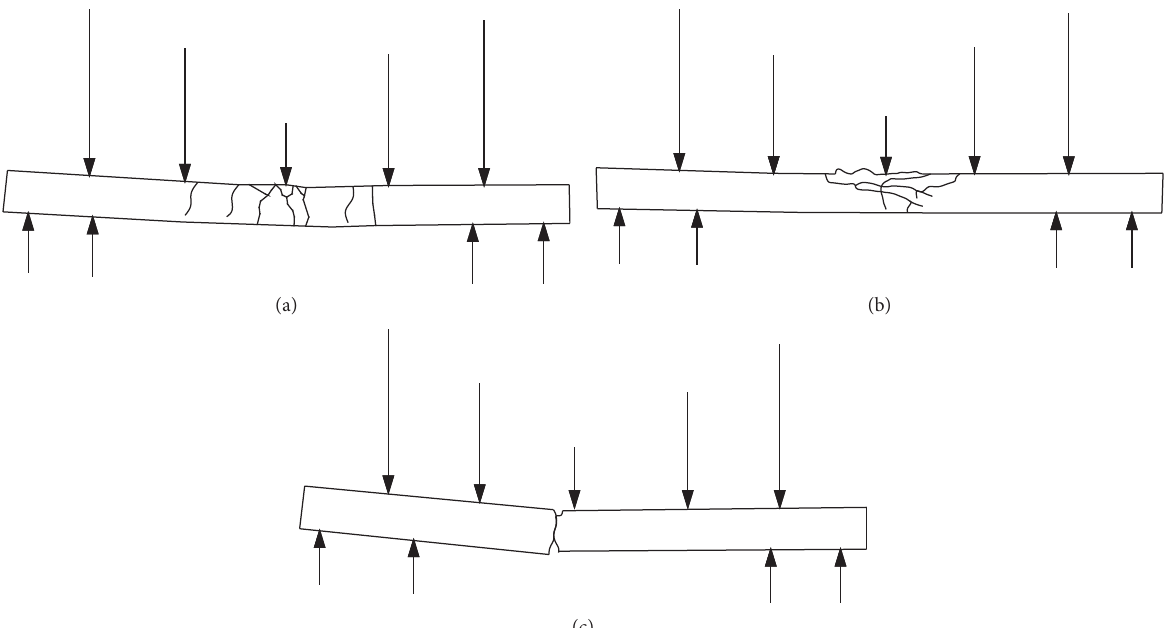
Figure 9: The failure form of normal section of thin immediate roof under uniform load. (a) The under-reinforced beam failure. (b) The over-reinforced beam failure. (c) The low-reinforced beam failure.